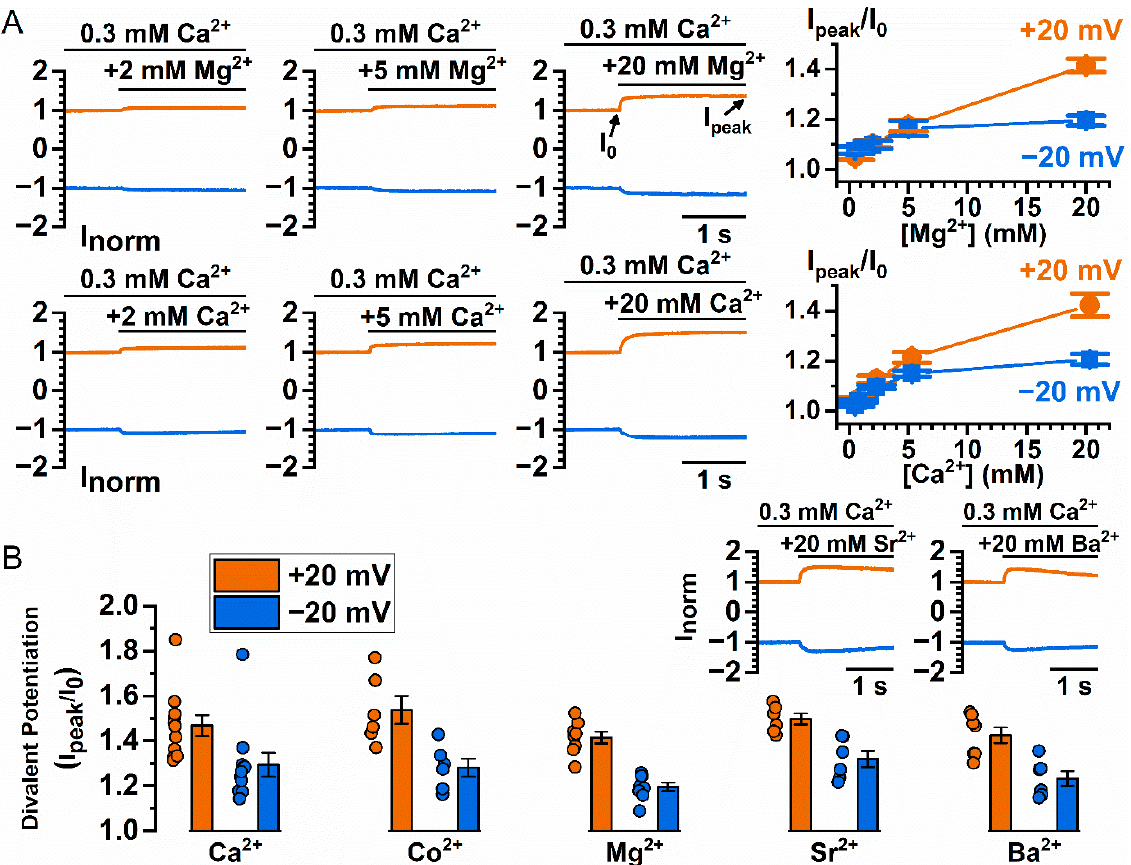
Figure 2. Potentiation of WT 16A current by various divalent cations. ( A ) Dose-dependent Mg 2+ and Ca 2+ potentiation of the WT 16A current. Left three panels show raw recording traces of Mg 2+ or Ca 2+ potentiation of WT 16A current. The currents were normalized to the current immediately before the application of mM intracellular concentration of magnesium ([Mg 2+ ]) or [Ca 2+ ]. Right panel shows averaged potentiation of WT 16A current as a function of [Mg 2+ ] ( n = 5–8) or [Ca 2+ ] ( n = 6–7). ( B ) Averaged potentiation of 0.3 mM [Ca 2+ ] i -induced WT 16A current by 20 mM Ca 2+ , Co 2+ , Mg 2+ , Sr 2+ or Ba 2+ ( n = 6–11). Insets show raw recording traces of Sr 2+ or Ba 2+ potentiation of WT 16A current.